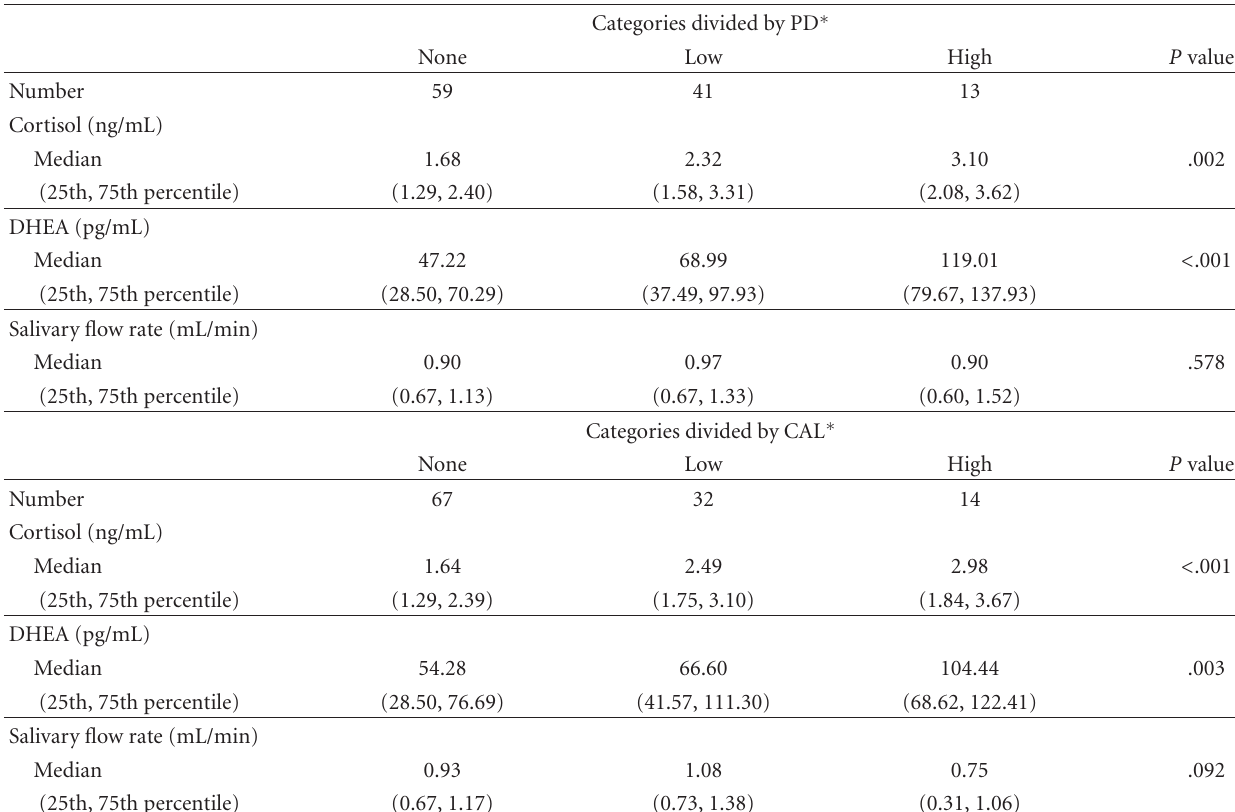
Table 3: Median values for salivary cortisol and dehydroepiandrosterone in presence or absence of extensive periodontitis in subjects who never smoked, divided by PD and CAL.